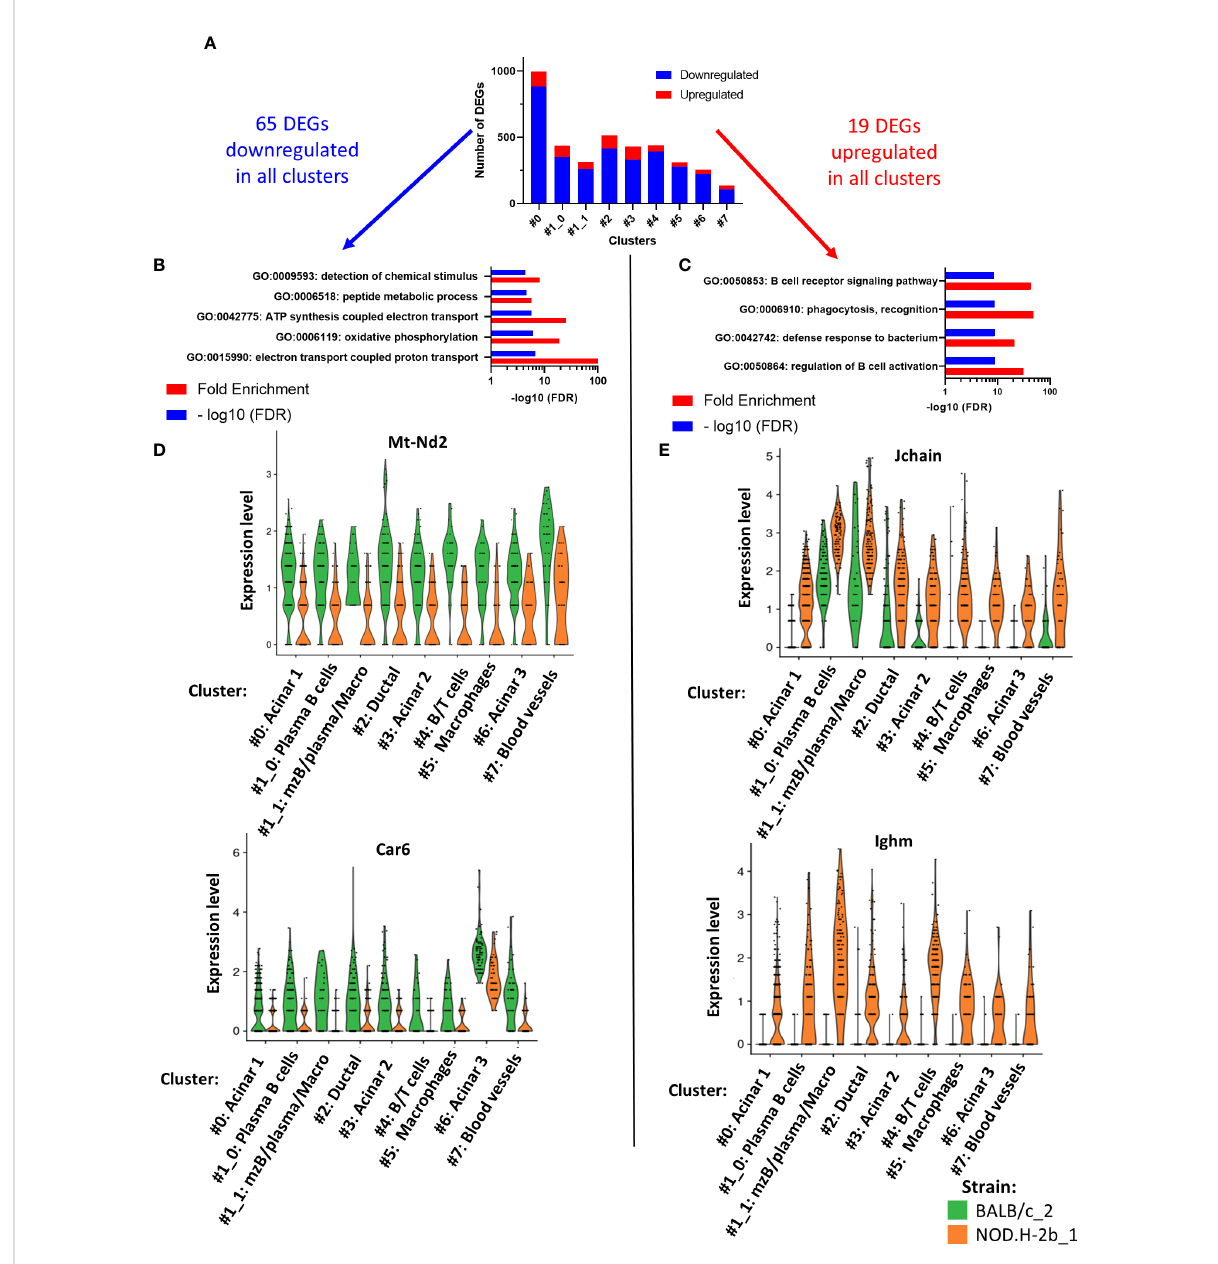
FIGURE 6 Pathways analysis of DEGs common to all cluster. (A) Bar plot showing number of DEGs upregulated (in red) and downregulated (in blue) per cluster. Within all DEGs, 65 were commonly downregulated in every cluster and 19 DEGs commonly upregulated in every cluster. (B) Four pathways are signi fi cantly enriched in DEGs downregulated and (C) four pathways are signi fi cantly enriched in DEGs upregulated. (D, E) Violin plot of DEGs involved in the pathways previously identi fi ed showing their expression in each cluster and depending on their origin: BALB/c (in green) and NOD mice (in